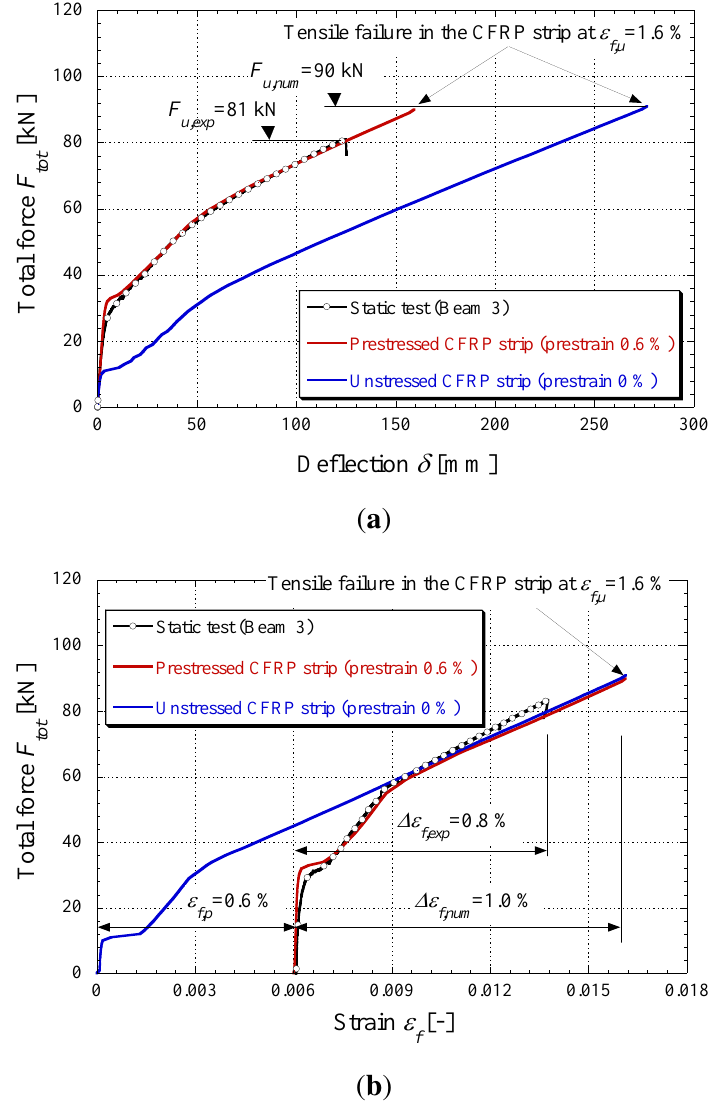
Experimental and numerical ( a ) force-deflection, total force F deflection δ and ( b ) force-strain at the midspan curves, total force F ε at the f